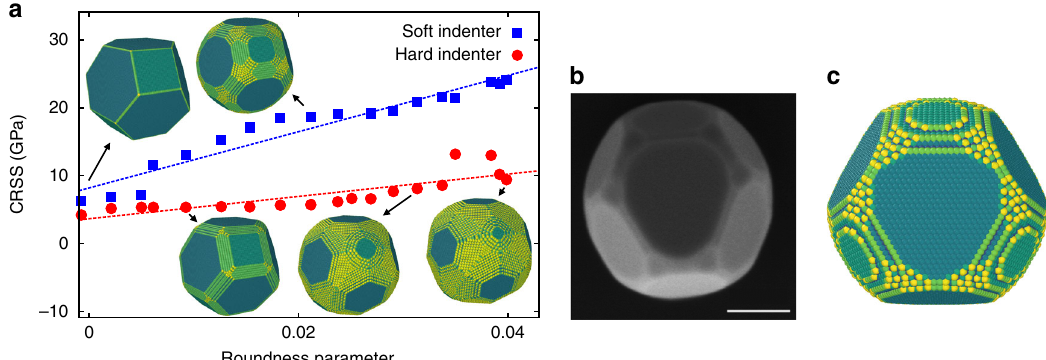
Fig. 5 Effect of particle roundness on compressive strength in MD simulations. a Compressive strength of a 20 nm nanoparticle in MD simulations with the hard and soft walls as a function of the particle roundness Γ ( Γ = 0 for the ideal Wulff shape). The lines are linear fi ts that only serve as a guide to the eye. Typical particle shapes are shown for comparison. b Typical experimental particle with a rounded Wulff shape. c Particle from MD simulations with similar roundness. The atoms are colored according to their energy with brighter colors representing larger energy. The scale bar in ( b ) corresponds to 200 nm